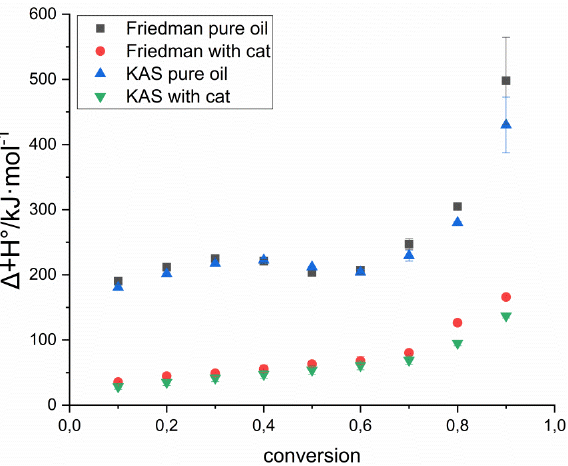
Figure 7. Dependency of the activation enthalpy vs. conversion for catalytic and non-catalytic peat pyrolysis.